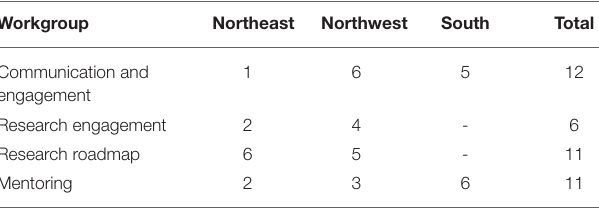
TABLE 5 | Stakeholder workgroups and participants by region. Workgroup Northeast